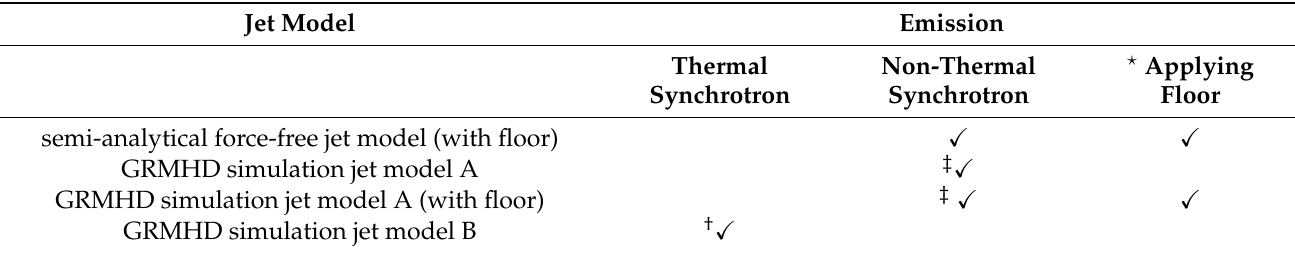
Table 4. Overview of Illustrative Models